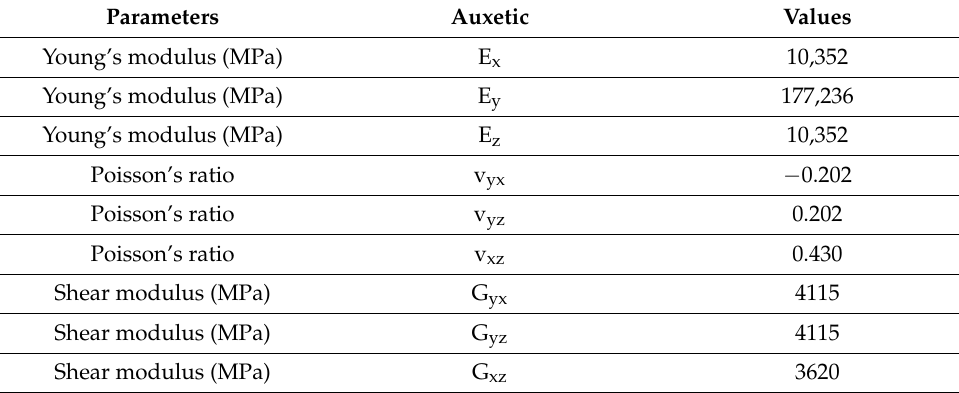
Table 7. Mechanical properties have been taken from